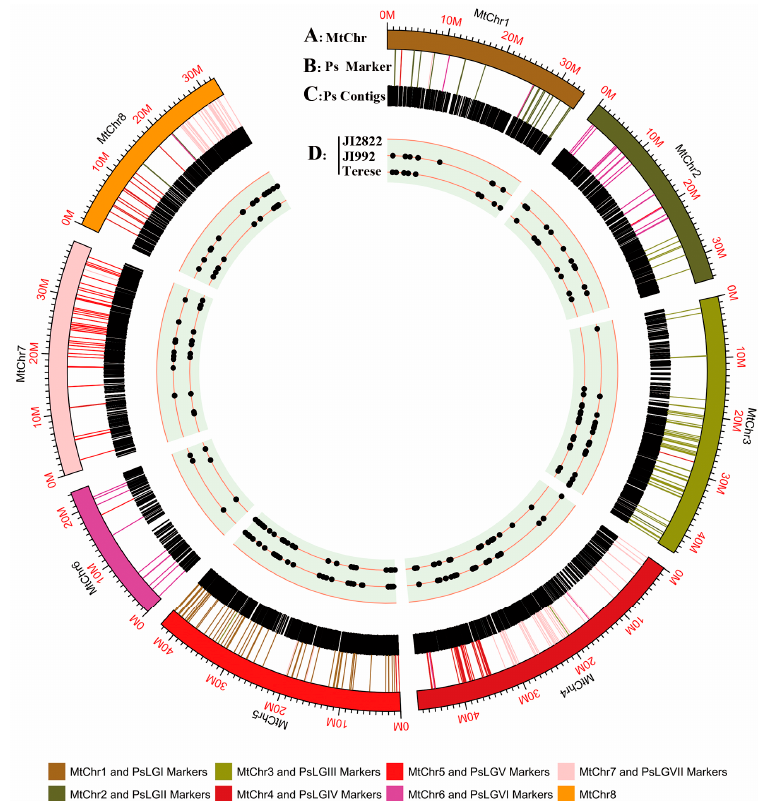
Figure 2. A comparative map between pea and Medicago. ( A ) Eight chromosomes of Medicago (Mt). ( B ) 324 unigenes that are located on the consensus map and can be successfully mapped to Mt genome. ( C ) 10,472 unigenes matching to the unique region of the Medicago reference genome. ( D ) SNPs among the JI2822, JI992, and Terese pea accessions. Different colors represent various Mt Chrs and PsLGs in ( A , B ). Dots in ( D ) represent SNPs among pea accessions JI2822, JI992, and Terese from 324 unigenes in ( B ).